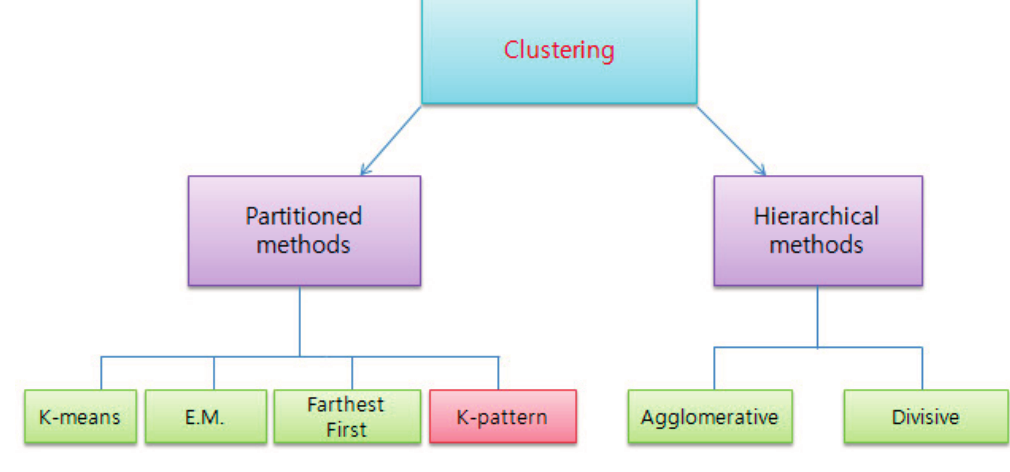
Figure 8. Basic taxonomy of clustering